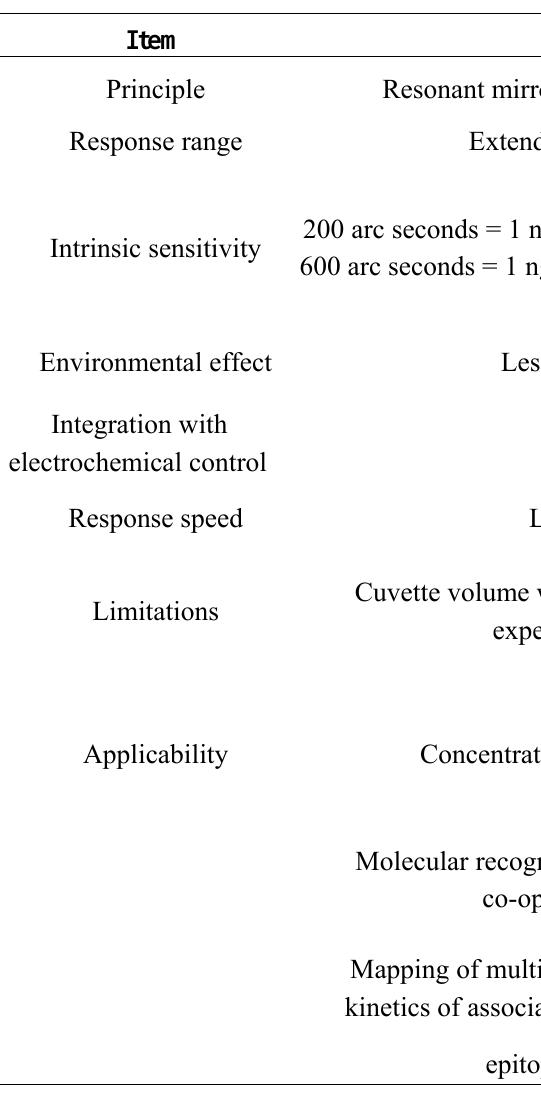
Table 3. Comparison of the IAsys and